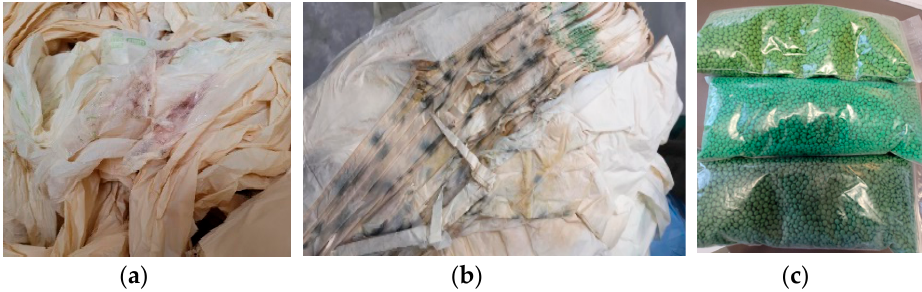
Figure 1. Mechanical recycling of PRE-CW from film fabrication starting from starch, PCL and PBAT compounds in the same films for packaging manufacturing ( a , b ) PRE-CW stored in uncontrolled conditions; ( c ) pellets mechanically recycled from PRE-CW.